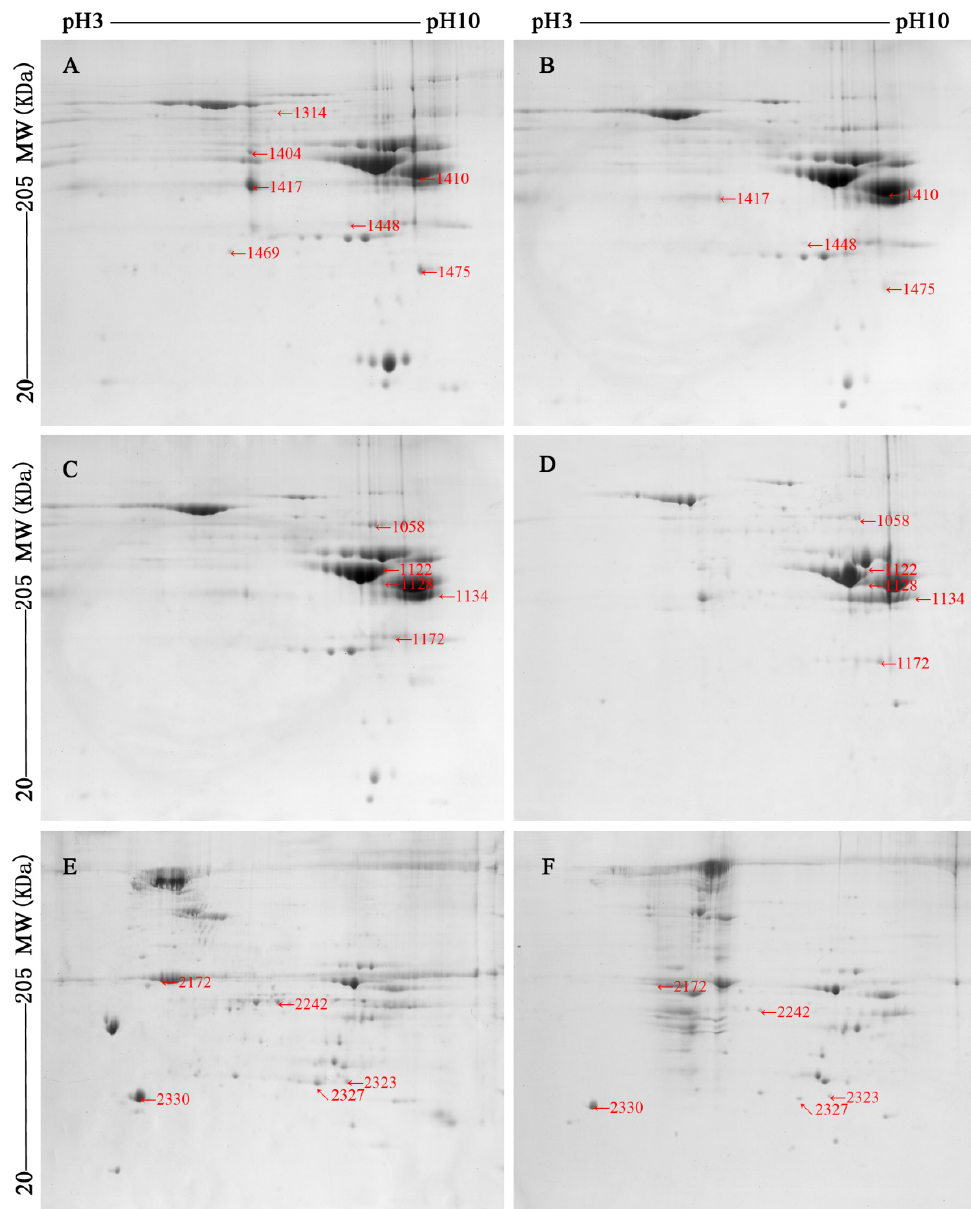
Figure 2. Two-dimensional gel images (pH range between 3 and 10 and molecular weight from about 20 to 205 kDa) of sarcoplasmic (( A , B ), the early of storage, day 1; ( C , D ), the late stage of storage, day 5) and myofibrillar (( E , F ), the late stage of storage, day 5) proteome from ovine M. longissimus lumborum (LL) and M. psoas major (PM)